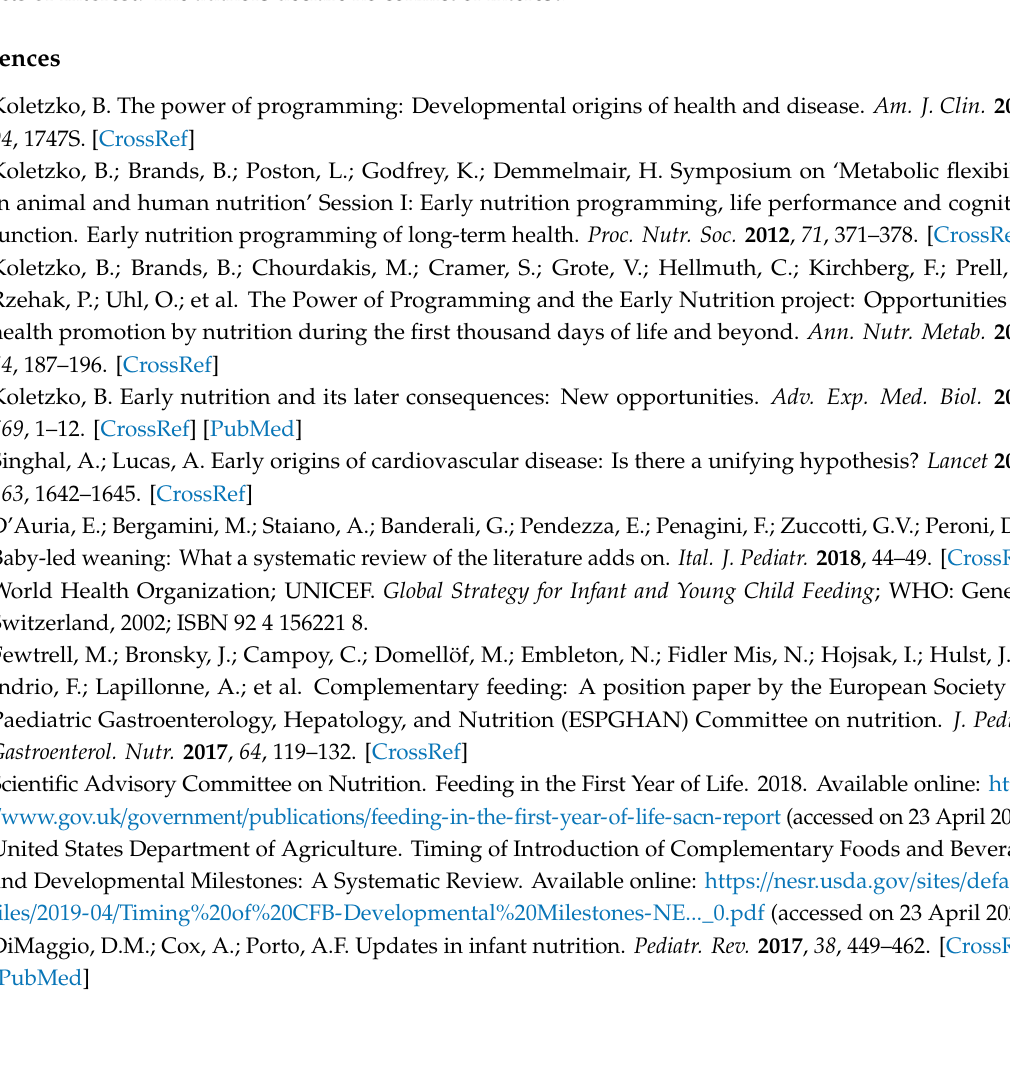
Table S1: Recommended daily intake for macro and micronutrients during the first year of